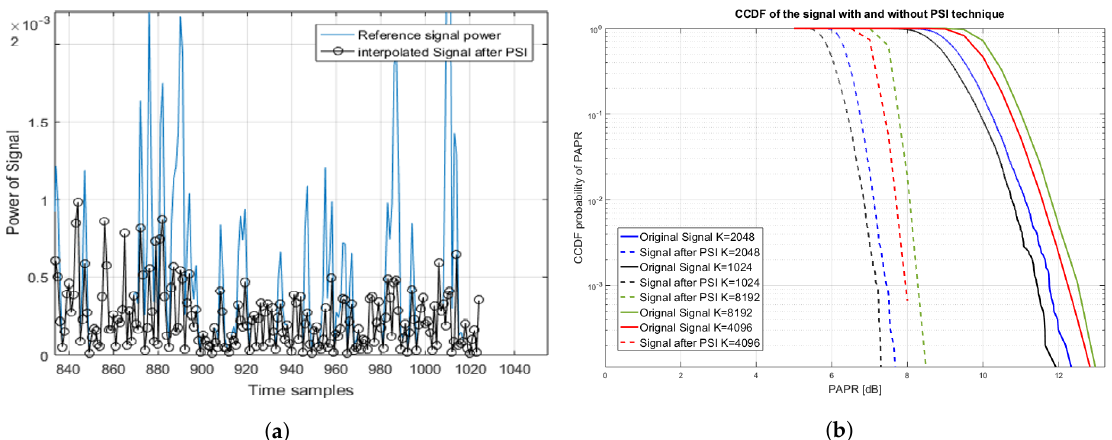
Figure 8. ( a ) Signal power before and after PSI technique [24]. ( b ) CCDF probability of PAPR before and after PSI technique for K = 1024, to K = 8192 [24].